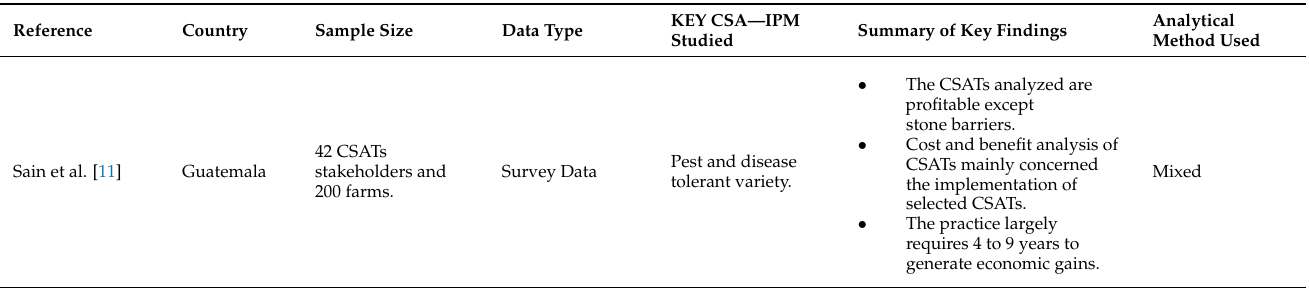
Table 1. Summary of some of the key studies